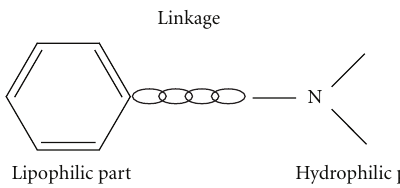
Figure 1: Structure of all local anaesthetics.